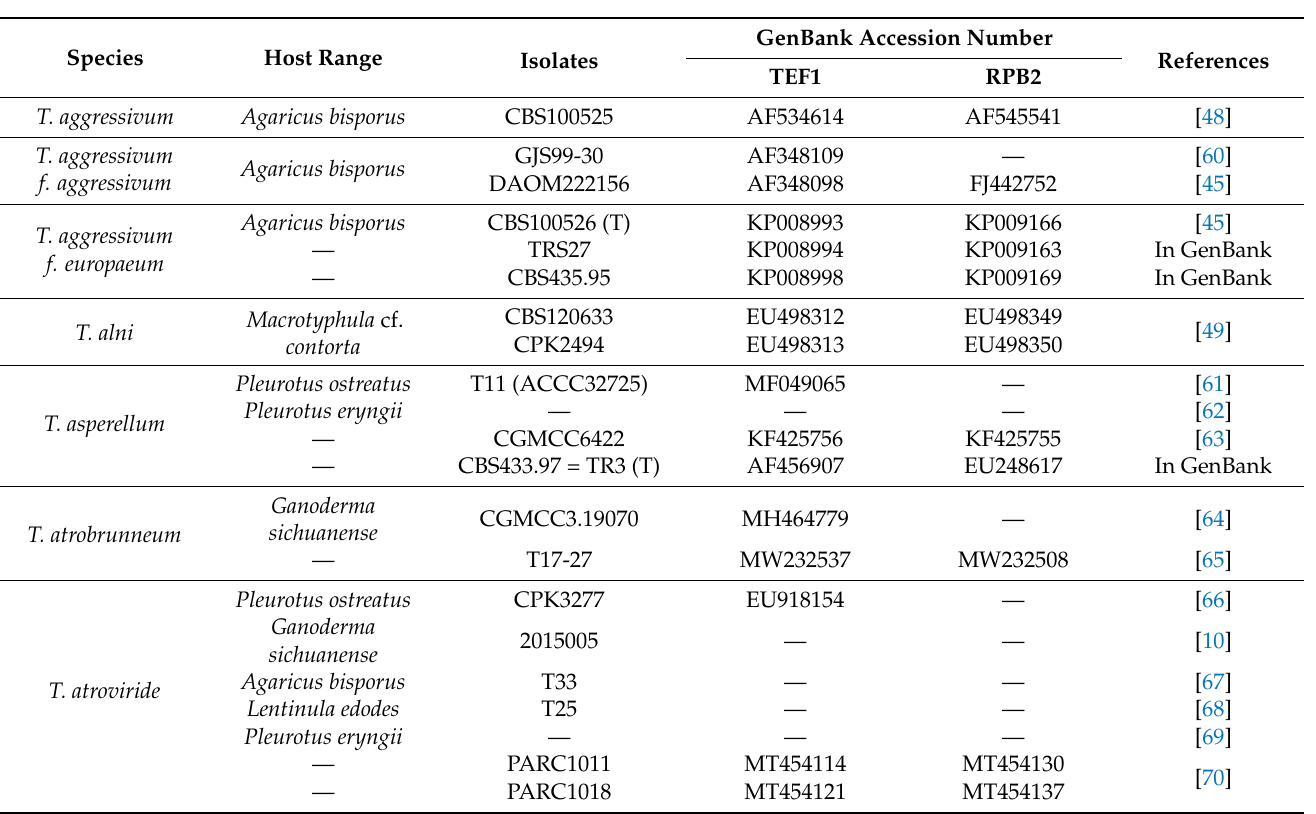
Table 2. Isolates and GenBank accession numbers of Trichoderma species associated with green mold on